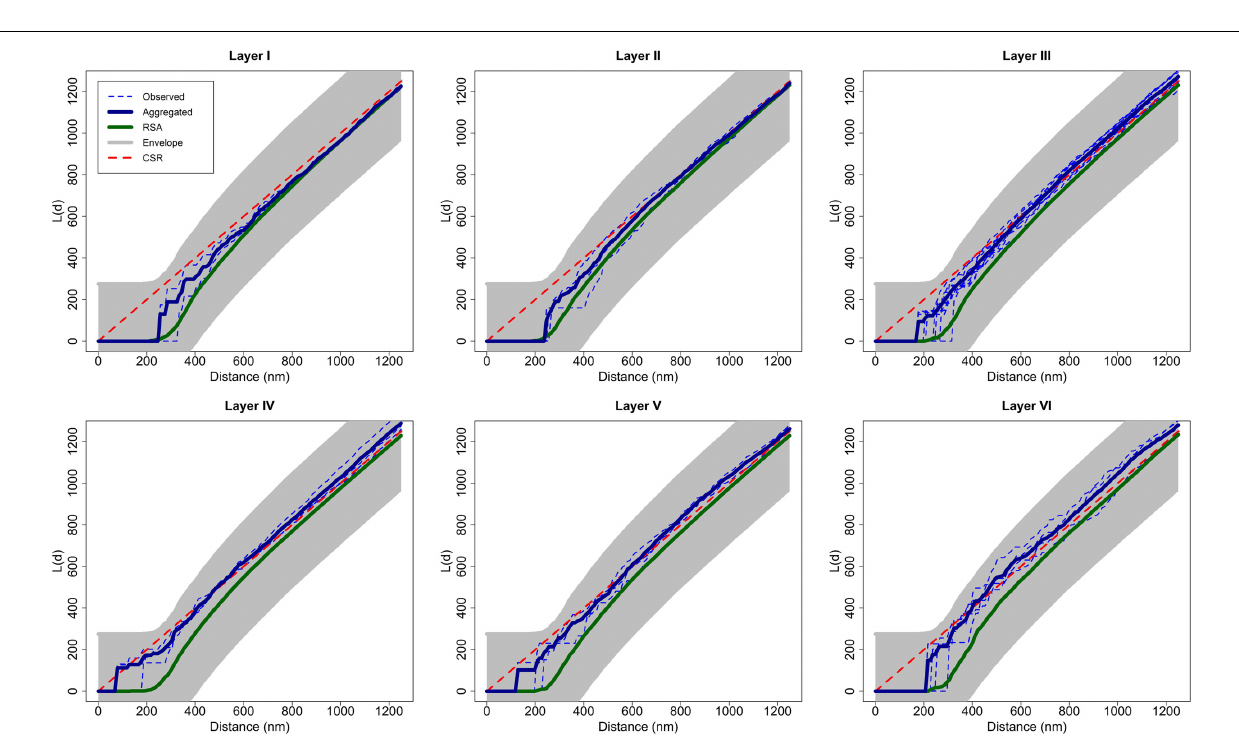
simulations. We do not reject the RSA model for any layer of the somatosensory cortex because all the aggregated L functions were within the boundaries of the envelopes. We added the theoretical L function for a random pattern (dashed red diagonal) for the purpose of visual comparison.